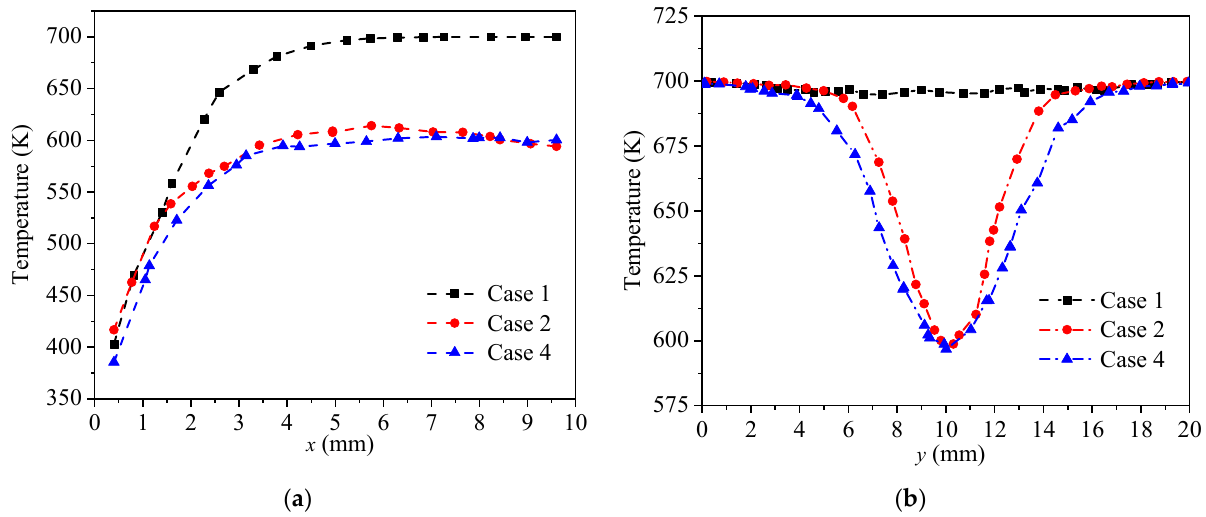
Figure 7. ( a ) Temperature distribution of Line 1 at t = 41 s; and ( b ) temperature distribution of Line 2 at t = 41 s. The heat transfer characteristics of particles flow around different surfaces under different cases are shown in Table 4. During the simulation time of 21–41 s, the particle contact number with the heat transfer surface is counted. The time-average unit area particle contact number directly describes the contact between particles and the heat transfer surface. The equation of the time-average unit area particle contact number is shown in Equation (6): where ν is the time-average unit area particle contact number; N is the number of particles; A is the surface area; and t is the time. The time-average unit area particle contact number of the static PFPU (Case 2) is smaller than that of the smooth plate (Case 1) due to the influence of the cavity zone generated by the particle flow around the pin-fin. When the PFPU oscillates along the Y